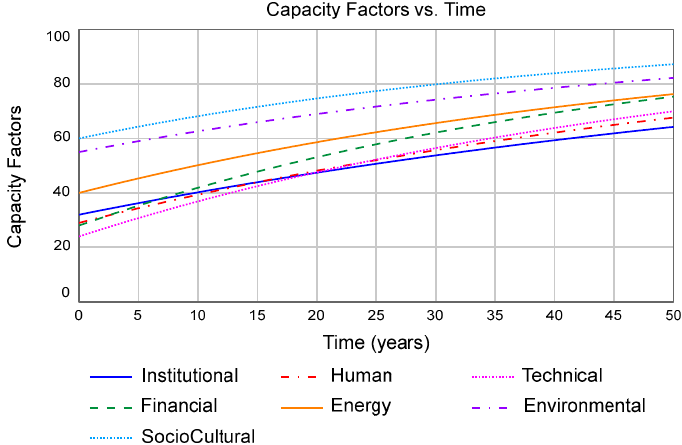
Figure 7. Variation of the seven capacity factors with time assuming capacity dependency and an enabling environment.